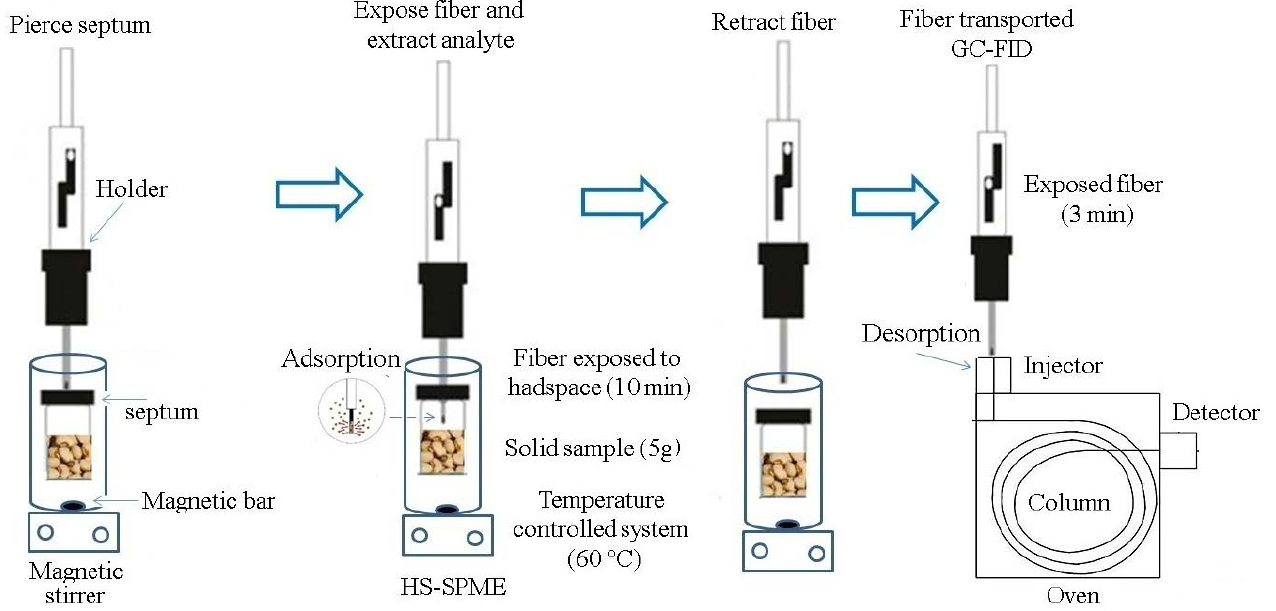
Figure 1. HS-SPME scheme for safrole analysis in cowpea beans samples. Source: Modified from Vilela et al. [48] and Moura et al. [14].